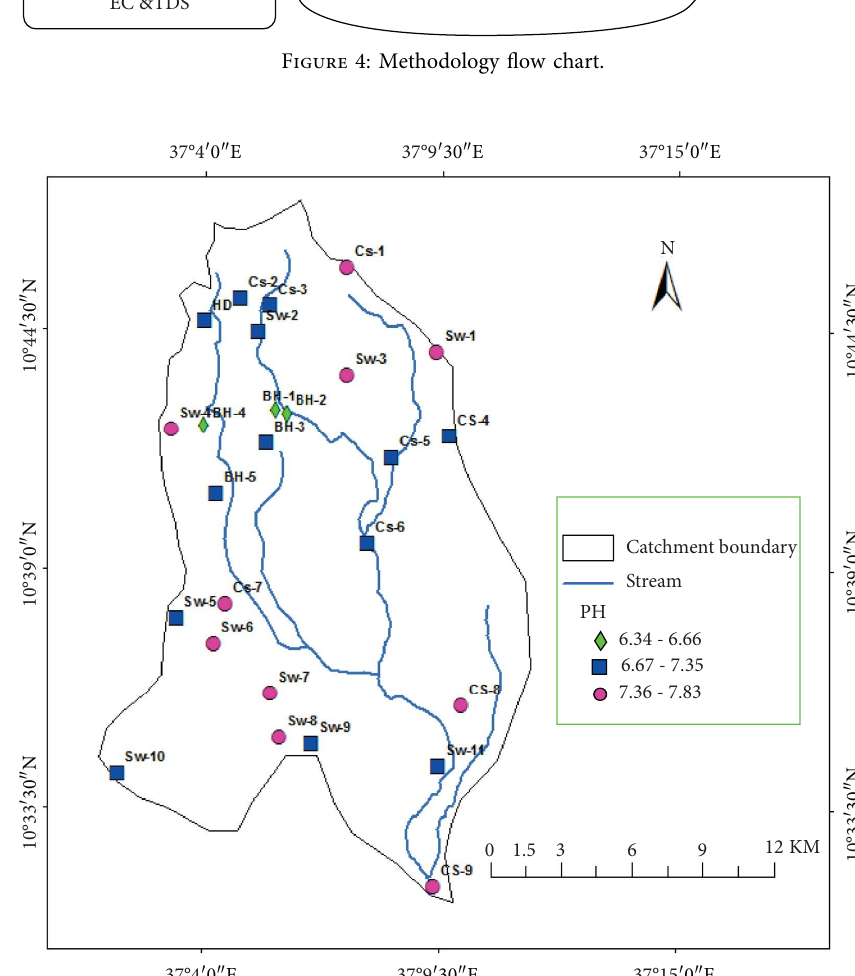
Figure 5: Spatial variability map of pH.